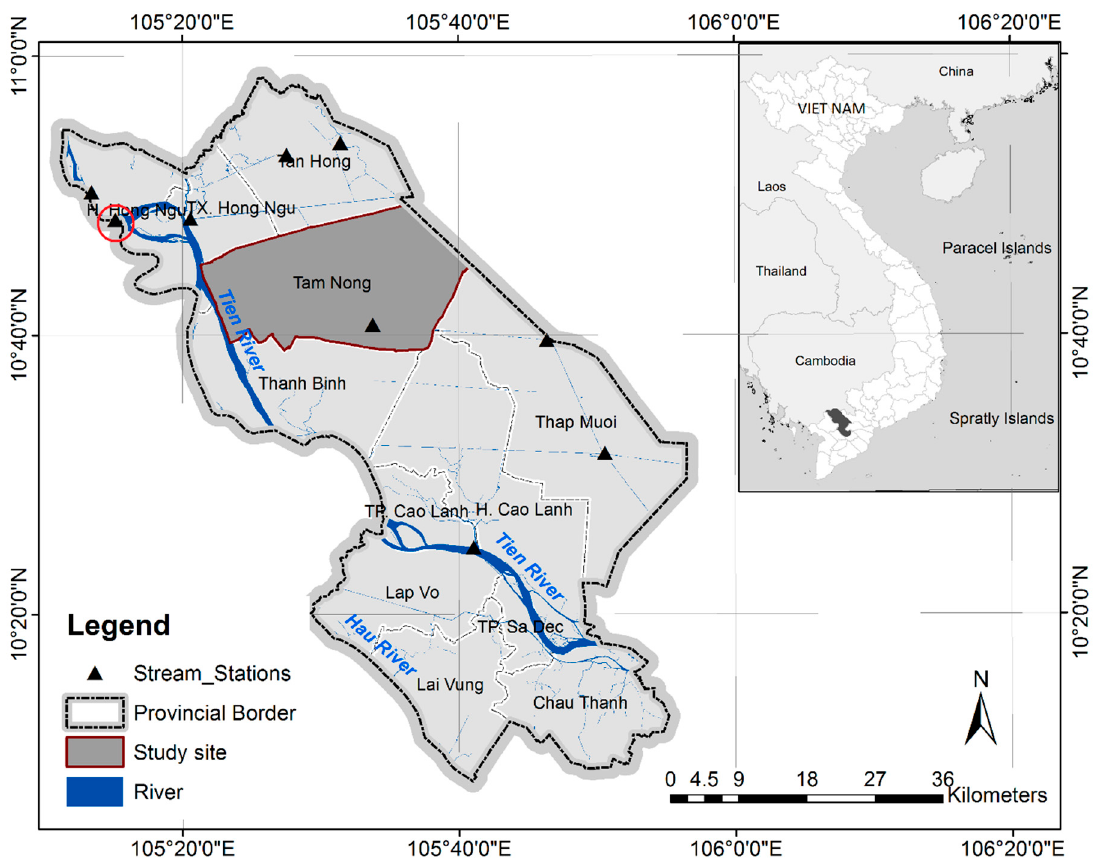
Figure 1. Site map of Tam Nong district in Dong Thap province (in the red polygon) located on the Vietnamese Mekong delta.